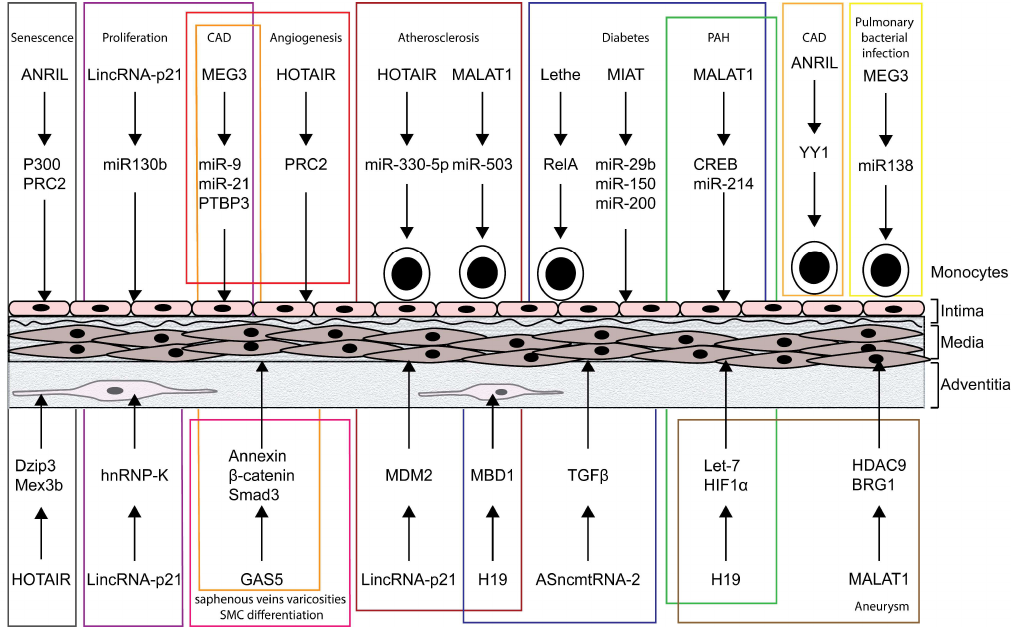
Figure 1. Long non-coding RNAs (LncRNAs) associated with vascular disease and age, and exerting a decoy, guide or scaffold function in endothelial cells, vascular smooth muscle cells, fibroblasts and/or immune cells. CAD: coronary artery disease; PAH: pulmonary arterial